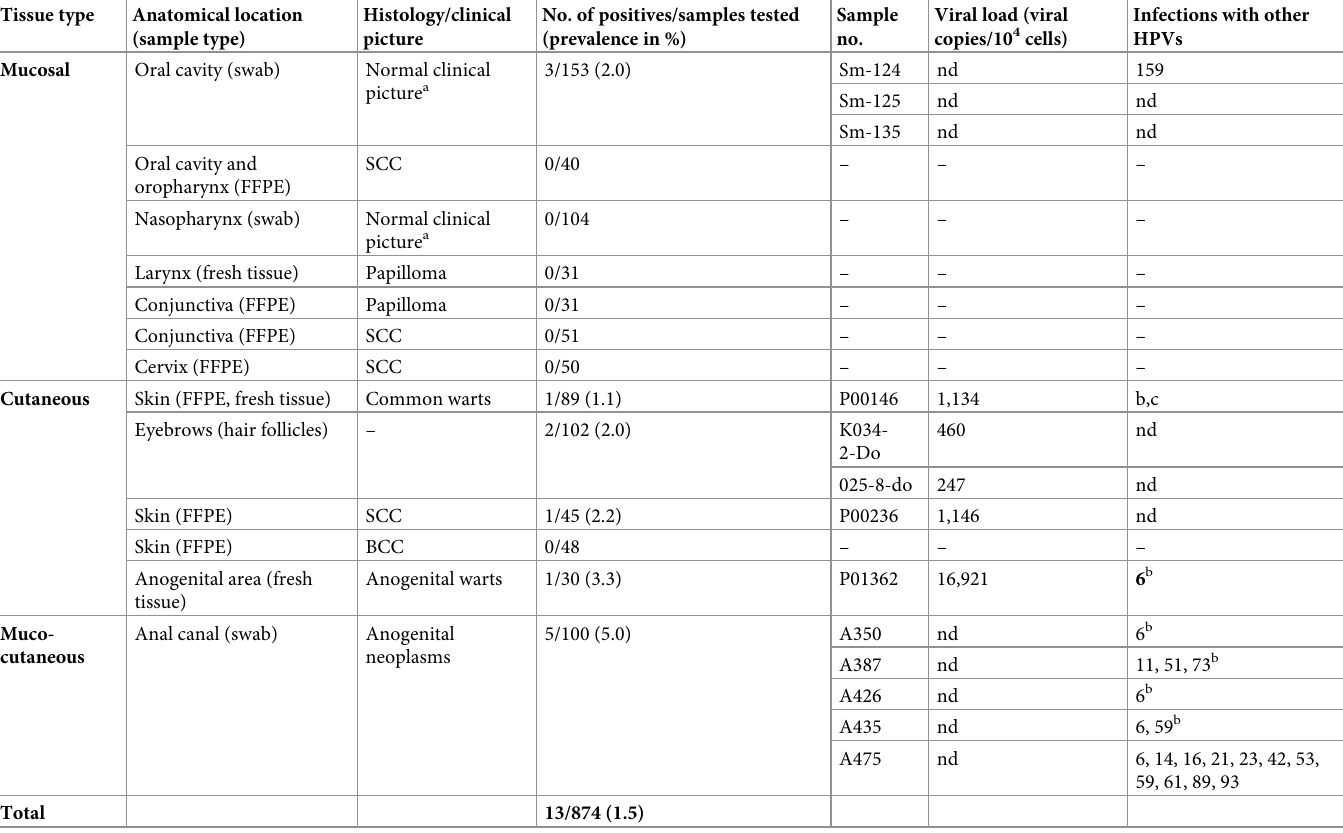
Table 3. Prevalence and tissue tropism of human papillomavirus type 146 (HPV146) in immunocompetent individuals. Tissue